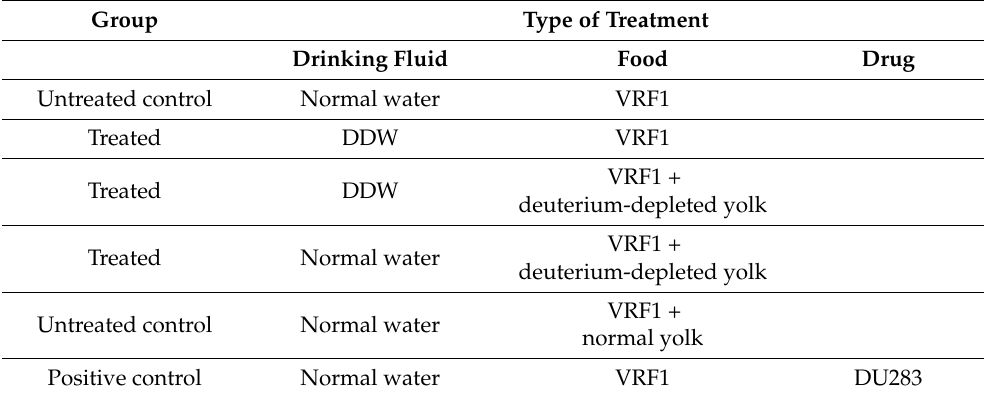
Table 1. Groups and treatments in the first mouse study using the 4T1 cell